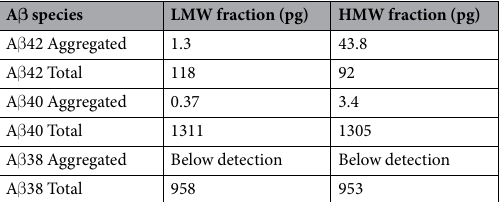
Table 1. A β Os are present in LMW and HMW fractions of AD brain extracts. LMW and HMW fractions from soluble extracts of 3 pooled AD brains were analyzed for amounts of total (MSD platform assay) and aggregated (A4 assay) A β 42, A β 40 and A β 38